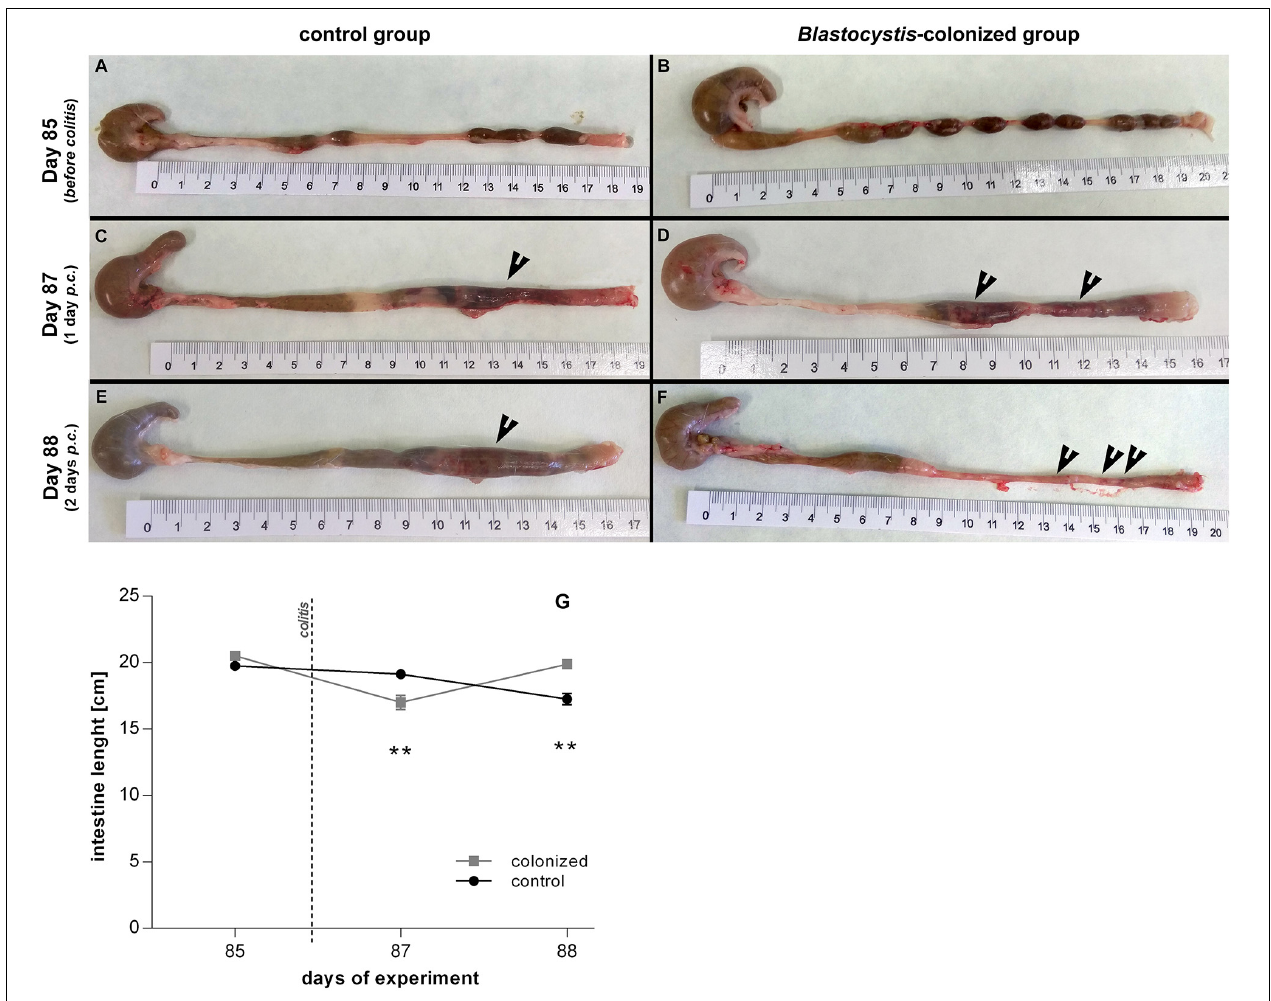
FIGURE 5 | Macroscopic evaluation of the intestine length between Blastocystis ST3-colonized and non-colonized (i.e., control) rats, also before and after the induction of moderate DNBS colitis induction. (A,B) Prior to induction of colitis (Day 85), without gut inflammation, the length of the intestine ranged between 19.5 to 20.5 cm in both groups – (A) intestine of non-colonized rats; (B) intestine of colonized rats. (C–F) After induction of colitis (Day 87 and 88), there were differences in the length of inflamed intestine between groups and days after colitis – (C,E) inflamed intestine of non-colonized rats was reduced to average 18–19 cm on Day 87 and to average 16 cm on Day 88 (black arrows indicate inflammation in the large intestine); (D,F) inflamed intestine of Blastocystis -colonized rats was reduced to average 16 cm on Day 87, while on Day 88 the intestine extends almost to the original length (i.e., approximately 19.5 to 20 cm; black arrows indicate inflammation in the large intestine). (G) Graphical visualization of the changes in the intestine length in both groups of rats over the course of colitis (Day 85, 87, 88; colonized rats are in gray squares, non-colonized in black dots). Differences between groups calculated with Welch’s t -tests followed by Benjamini–Hochberg correction. Error bars are standard errors; * P = 0.05–0.01, ** P = 0.01–0.001. *** P <